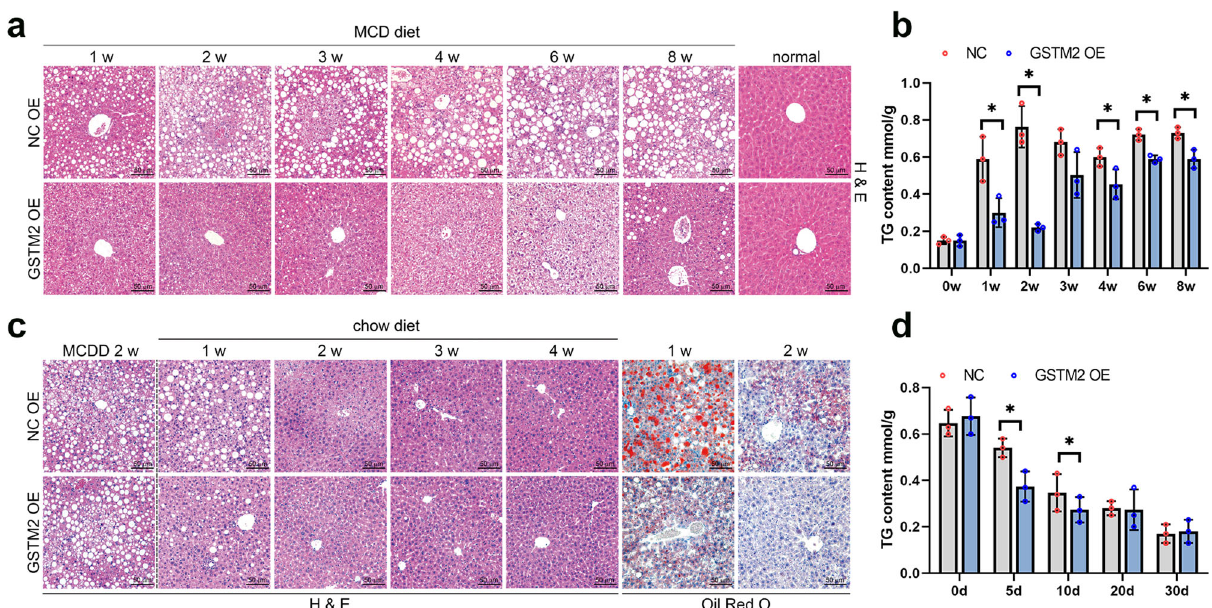
Fig. 2 GSTM2 overexpression protected against hepatic fat storage. a HE staining analysis of liver samples of GSTM2 overexpression (OE) and control mice challenged with MCDD at 1 w, 2 w, 3 w, 4 w, 6 w, and 8 w. b Hepatic TG concentrations of GSTM2 OE and control mice with MCD diet treatment at 0 w, 1 w, 2 w, 3 w, 4 w, 6 w, and 8 w; * p < 0.05. c Oil red O staining analysis of liver samples of GSTM2 OE and control mice fed MCDD for 2 w and then chow diet. d Hepatic TG concentrations of corresponding mice in ( c ); * p < 0.05. bar, 50 μ